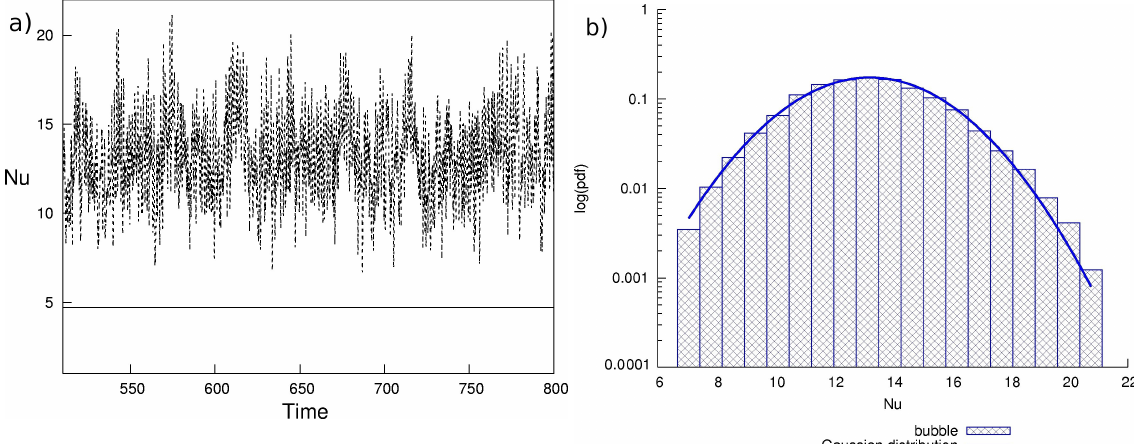
Figure 1. ( a ) Nusselt number time history number for Γ = 1/2, Ra = 2 × 10 5 and Pr = 1.65. Solid line indicates the flow without bubbles and the dashed line indicates the two-way coupling case. ( b ) Probability density function (pdf) of the Nusselt number time series compare with the Gaussian